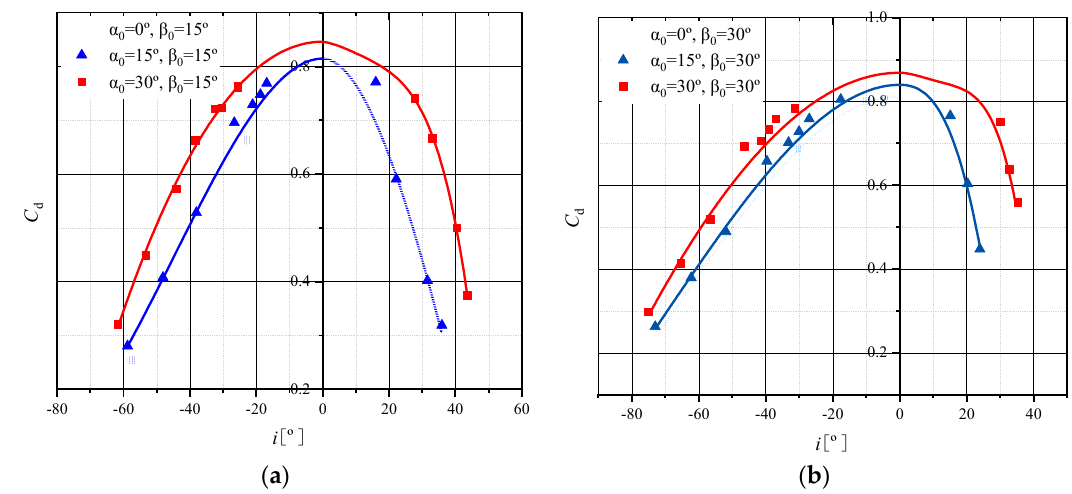
Figure 29. Relationship between C d and i under the condition of same β 0 and different α 0 ( a ) β 0 = 15 ◦ with different α 0 ; ( b ) β 0 = 30 ◦ with different α 0 The cases with a fixed circumferential angle of 15° ( 𝛽